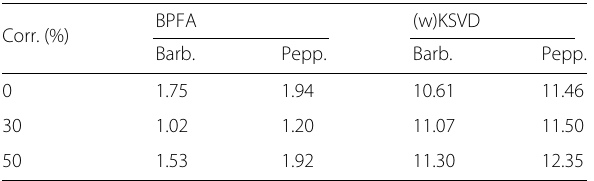
Table 3 Speed-up of ITKrM(M) over (w)KSVD and BPFA, corresponding to the average runtime of wKSVD/BPFA divided to that of ITKrMM using all available (corrupted) image patches of Barbara and Peppers Corr. (%)